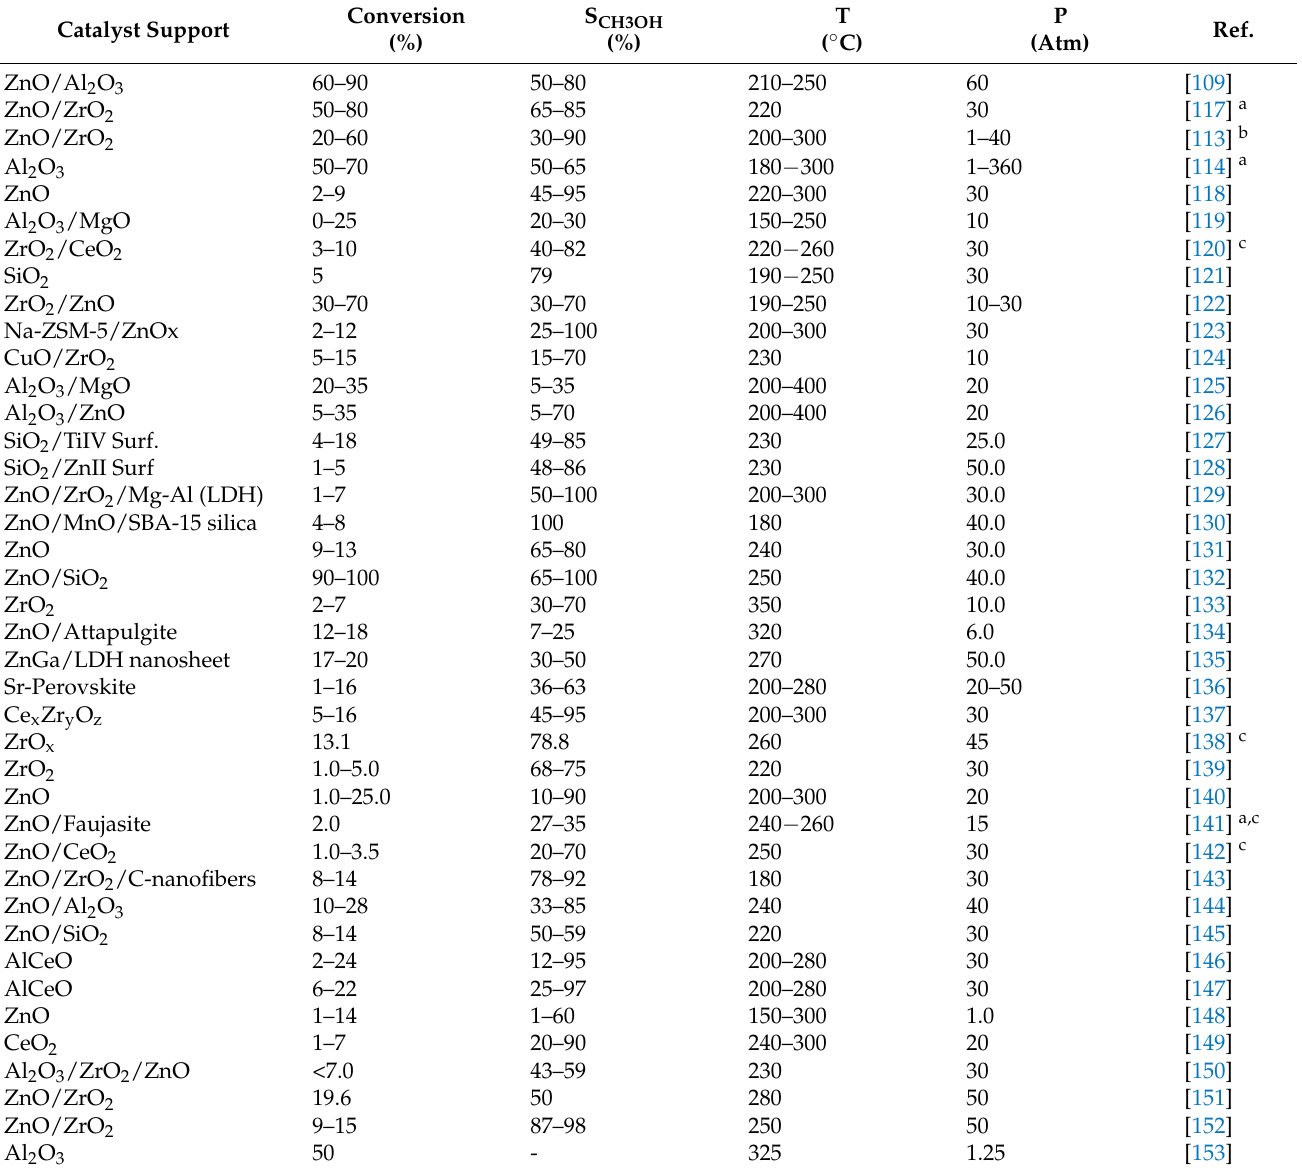
Table 3. Comparative performance of different Cu supported catalysts in the carbon dioxide hydro- genation to methanol reaction obtained by using different solid supports and/or different